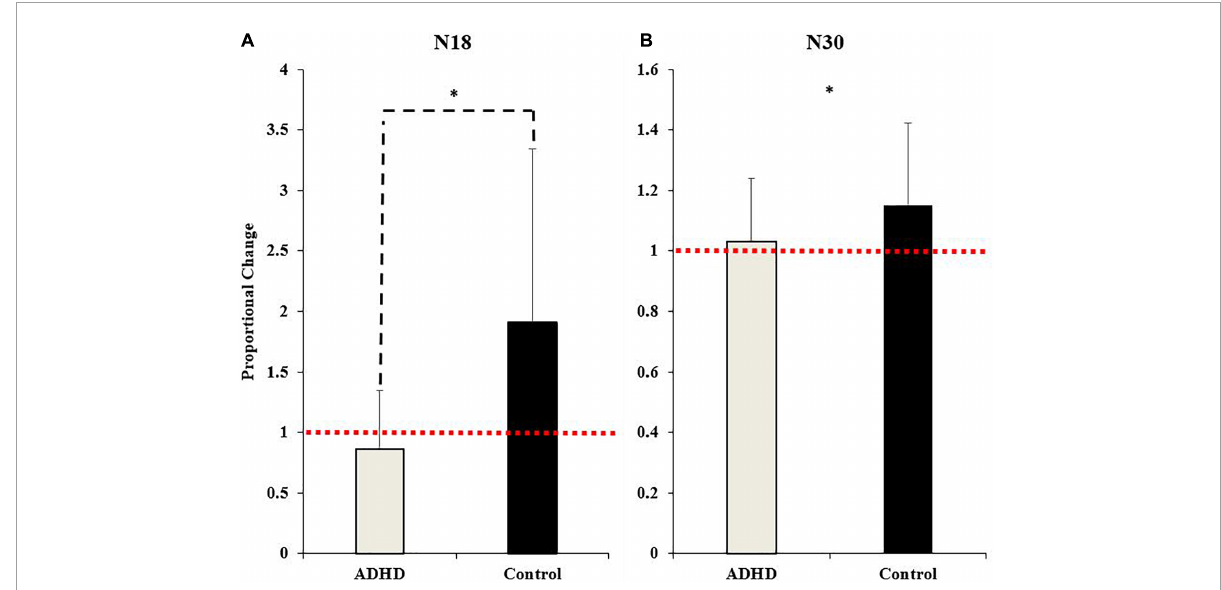
FIGURE7 Normalized SEP peak amplitudes relative to baseline (red dotted line) for the N18 (A) and the N30 (B) . ADHD participants are in gray and controls are in black. Values represent mean ± SD. Dashed bars (- - -) and asterisks ( ∗ ) denote significant group interactions, and asterisks ( ∗ ) only indicate significant effects of